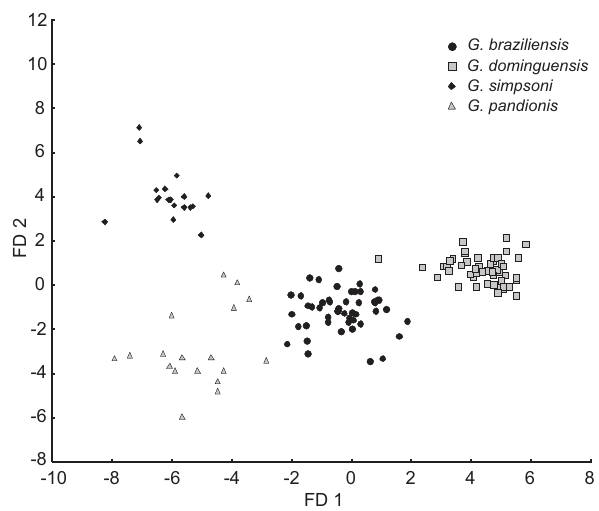
Figure 9. Results from Discriminant Analysis for the species of Gadila .